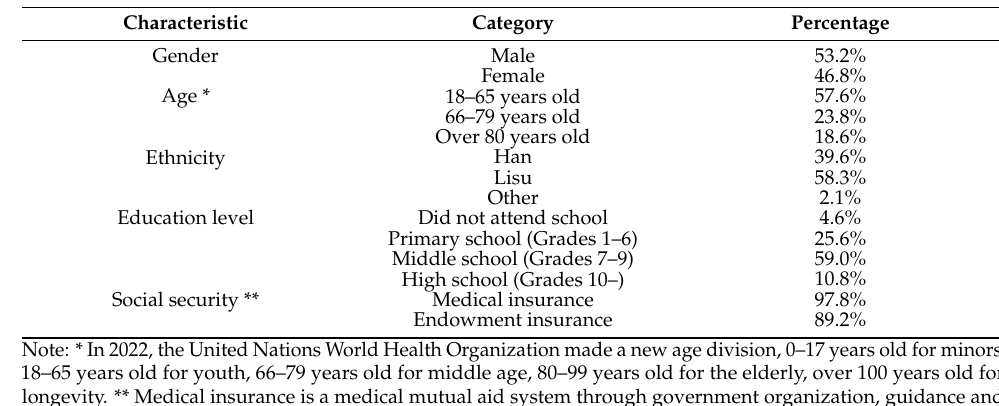
Table 9. The basic information of the participating households.